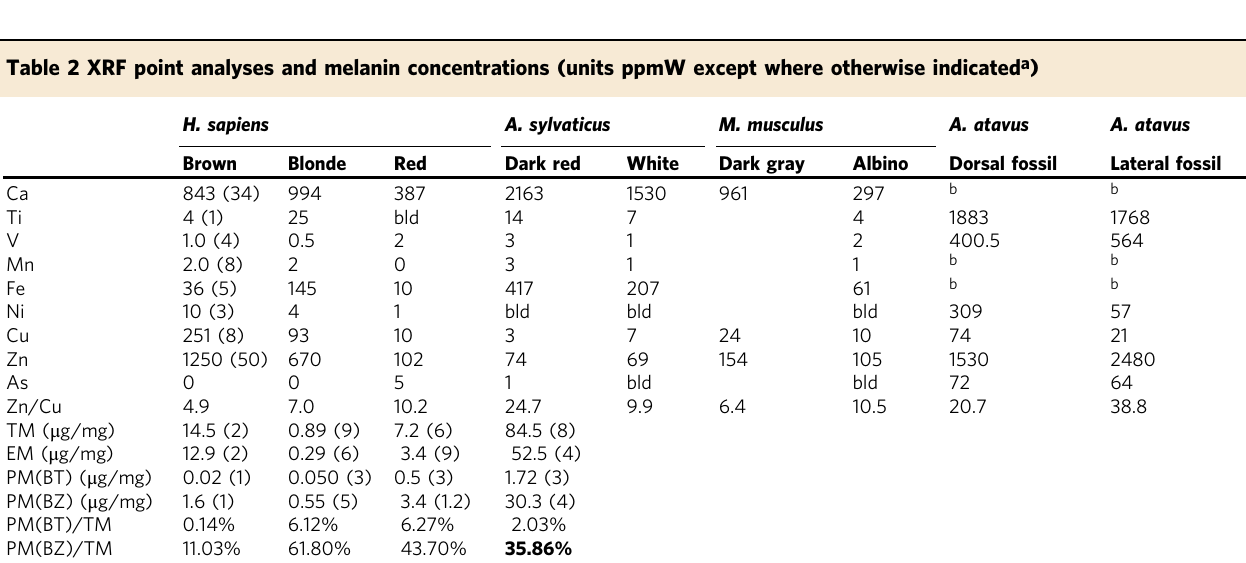
a 2 σ errorsonconcentrationsduetocountingstatisticsrangefrom4%(e.g.,Ca,Zn)to40%(e.g.,Mn)relative,withindicativeerrorsfortheconcentrationrangespresentedheregiveninthe fi rstcolumn as errors on the terminal digits in parentheses b Not discriminated from sedimentary matrix background. Point analyses from SSRL beamline 6-2 and DLS beamline I18. Standard error for the terminal digits of the melanin data also shown in parentheses TM = EM + PM(BT) + PM(BZ). TM indicates total melanin, EM is eumelanin PM(BT): Pheomelanin derived from benzothiazine (BT) units, as determined by hydroiodic acid hydrolysis – HPLC PM(BZ): Pheomelanin derived from benzothiazole (BZ) units, as determined by AHPO – HPLC